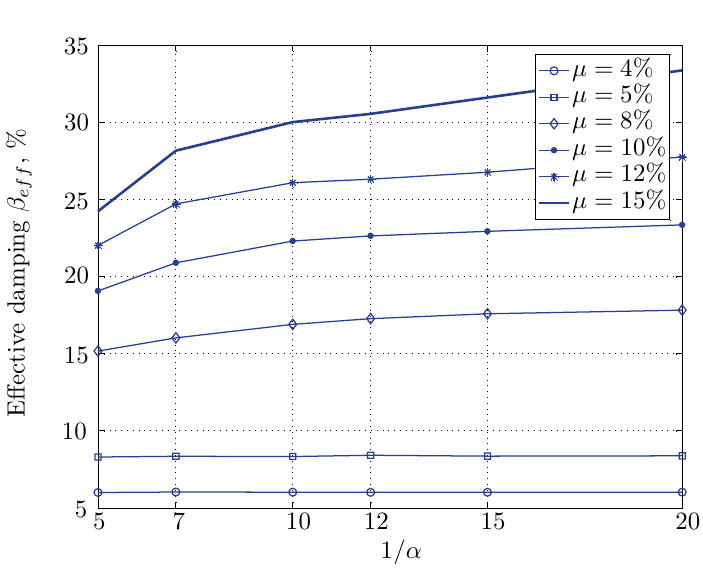
Figure 16. Effective damping for various isolation system parameters (El Centro